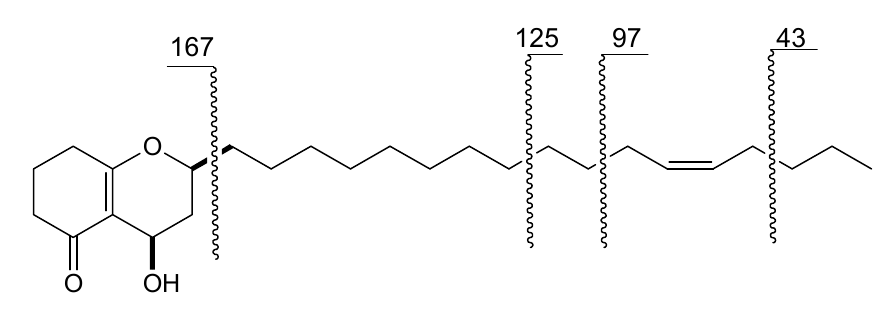
Figure 3. Key 1 H- 1 H COSY and HMBC correlations of 1